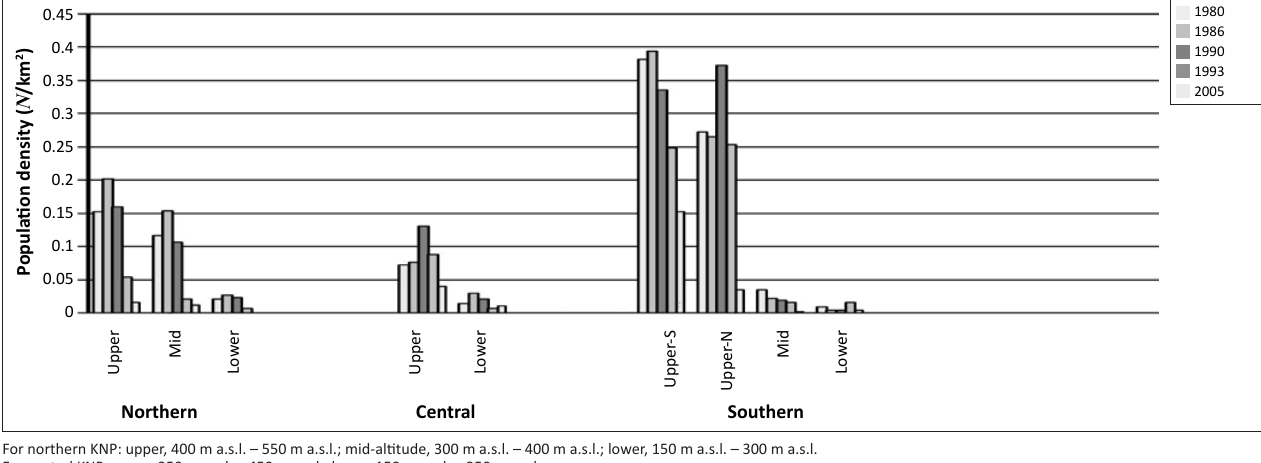
FIGURE 10: Population densities of sable antelope in subregions of the Kruger National Park (1980–2005), differentiated into broad classes of